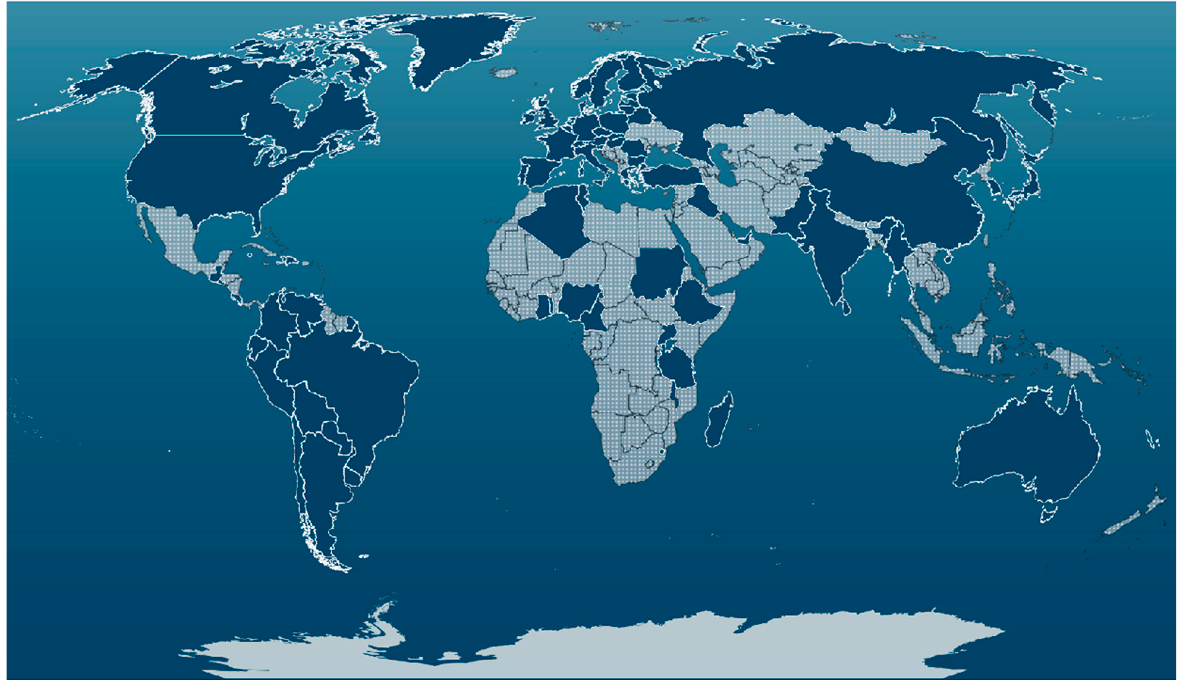
Fig. 6. Countries with access to Charter services in March 2021 (dark